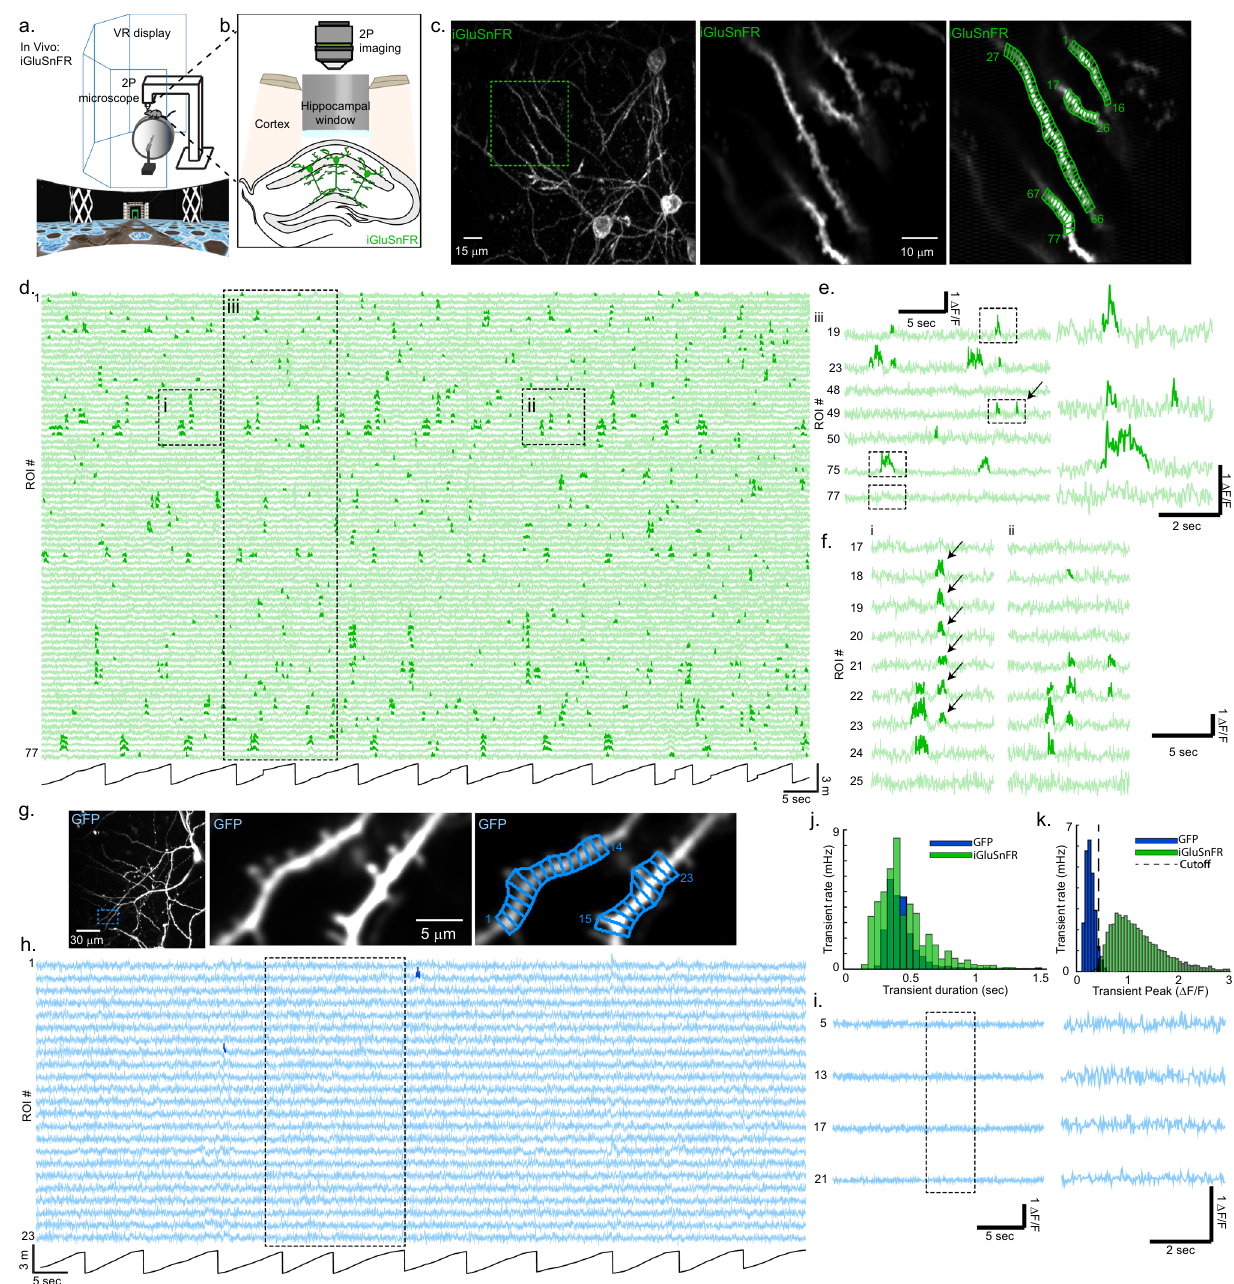
Fig. 1 Optical recording of excitatory input to CA1 neuron dendrites during spatial behaviors. a Schematic of behavioral apparatus (top) and an example of the virtual linear track (bottom). b Schematic of hippocampal imaging window used to image CA1 pyramidal neurons expressing iGluSnFR with 2P microscopy during spatial behaviors in VR. c Left, example z-projection image of CA1 pyramidal neurons expressing iGluSnFR and imaged during behavior. Middle, mean image from time series acquired at a single imaging plane (from the region shown at the left). Right, same as middle, but with 77 1- µ m ROIs shown in green. Similar results were obtained in 54 sessions from 11 mice. d iGluSnFR Δ F/F vs. time traces for each ROI shown in ( c , right) acquired during linear track navigation (track position at the bottom, black). Signi fi cant transients highlighted in bold. e Left, expanded scale of a subset of traces shown in region iii from panel ( d ); arrow, example transients restricted to 1 ROI. Right, expanded scale of traces shown dashed at the left. f Left, expanded scale of traces shown in region i from panel ( d ) showing synchronous transients occurring over adjacent ROIs 18 – 23, marked with arrows. Right, expanded scale of traces shown in region ii from panel ( d ) showing transients in only some of the ROIs that were synchronously active in region i. Panel ( g ) same as panel ( c ), but neurons expressing GFP. Similar results were obtained in 13 sessions from 4 mice. Panel ( h ) same as panel ( d ), but from ROIs shown in panel ( g , right). i Left, expanded scale of traces shown in the dashed region in panel ( h ). Right, expanded scale of traces shown dashed at the left. j , k . Histograms of durations ( j ) and peaks ( k ) of all signi fi cant iGluSnFR or GFP fl uorescence transients from all 1 µ m ROIs from all CA1 dendritic imaging sessions during behavior. Signi fi cant iGluSnFR transient amplitude cutoff threshold shown by a dashed line. GFP: n = 19 dendrites from 13 independent sessions from 4 mice. iGluSnFr: n = 109 dendrites from 54 independent sessions from 11 mice. Source data are provided as a Source Data fi le. VR virtual reality, 2P two- photon microscopy, ROI region of